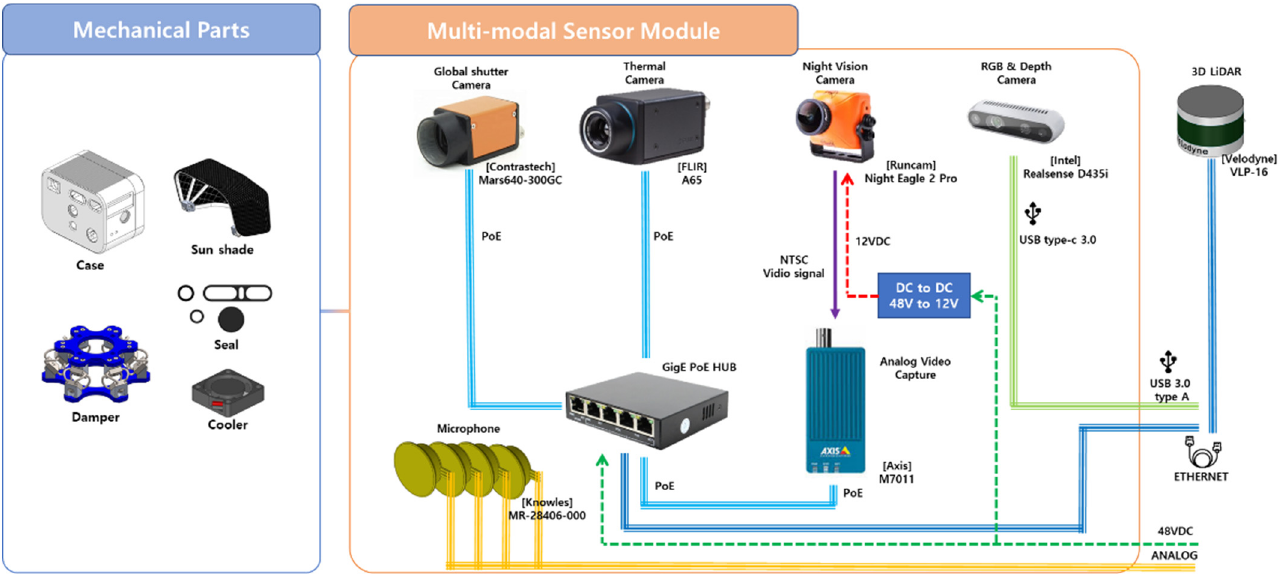
Figure 1. Multi-modal sensor system configuration.